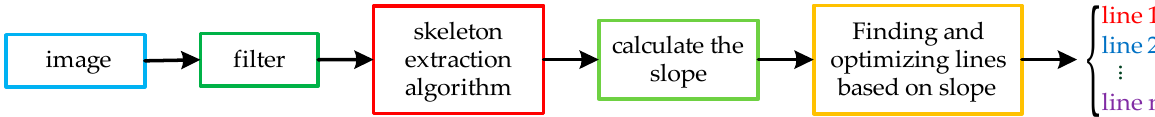
Figure 10. The process of line segment extraction. First, filtering is used to remove the burrs from the image, and existing skeleton extraction algorithms are used to extract the image algorithm. Then, we calculate the slopes of the points and optimize the slopes accordingly. Finally, we judge all lines according to the specified rules.